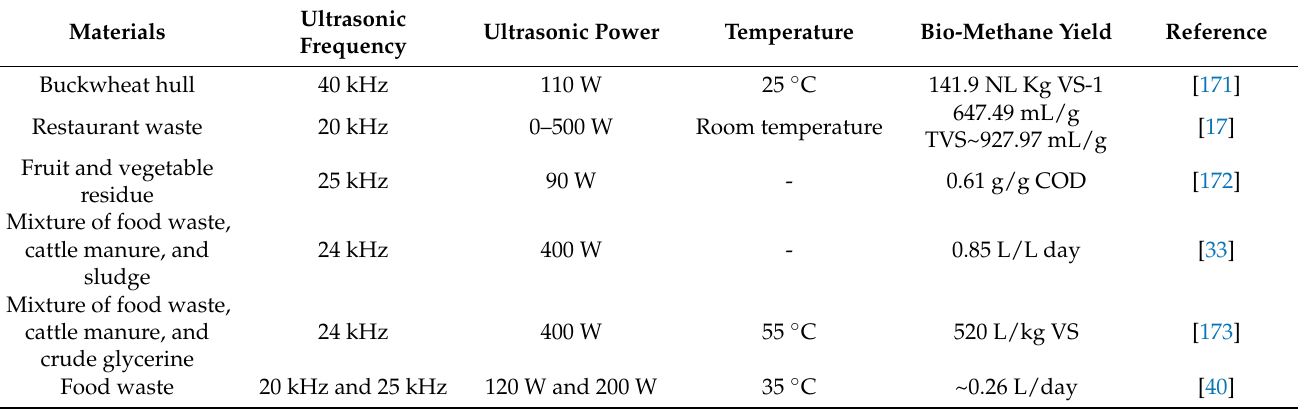
Table 4. Effect of ultrasound on bio-methane production from food waste during anaerobic